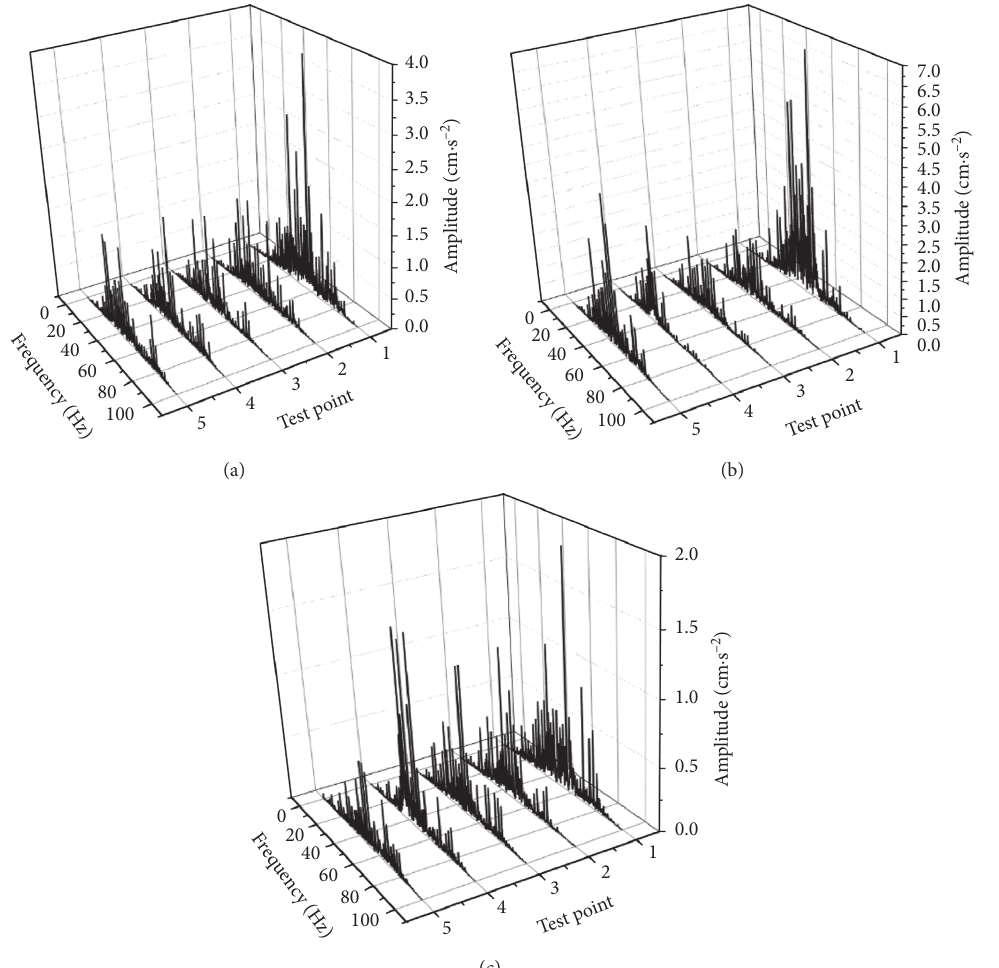
Figure 6: Acceleration spectra in the three directions at different test points when train no. 2 passed. (a) X direction. (b) Y direction. (c) Z